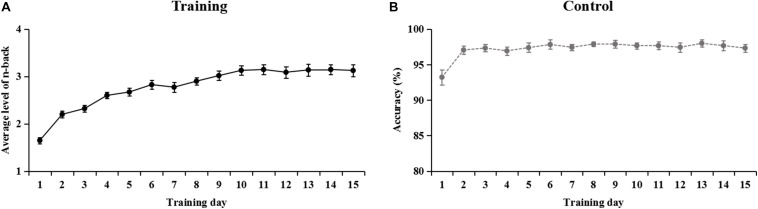
Training performance on the dual n-back task (A) and the visual search task (B) across training days. For the training group, the average level of n-back is reported for each training session. For the control group, the graph depicts the accuracy per day in the visual search task. Error bars denote standard error.